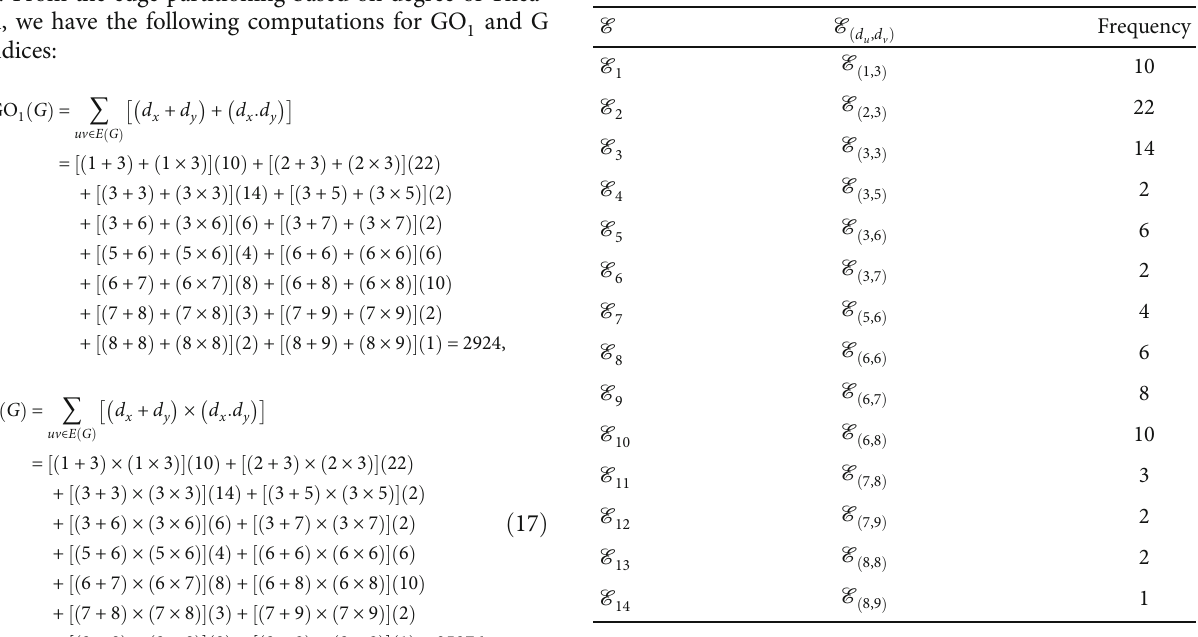
Figure 9: Molecular graph of Thea fl avin. Table 4: Edge partitioning based on degree of Thea fl